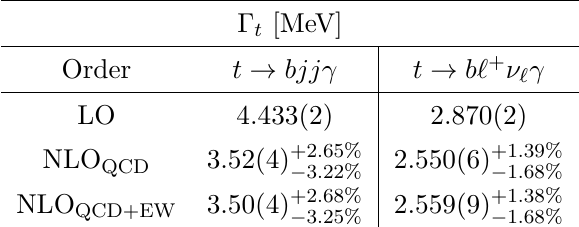
Table 5 . Top-quark hadronic ( t → bjjγ ) and leptonic ( t → b‘ + ν ‘ γ ) partial decay widths. The leptonic case includes all the three leptons e, µ and τ .